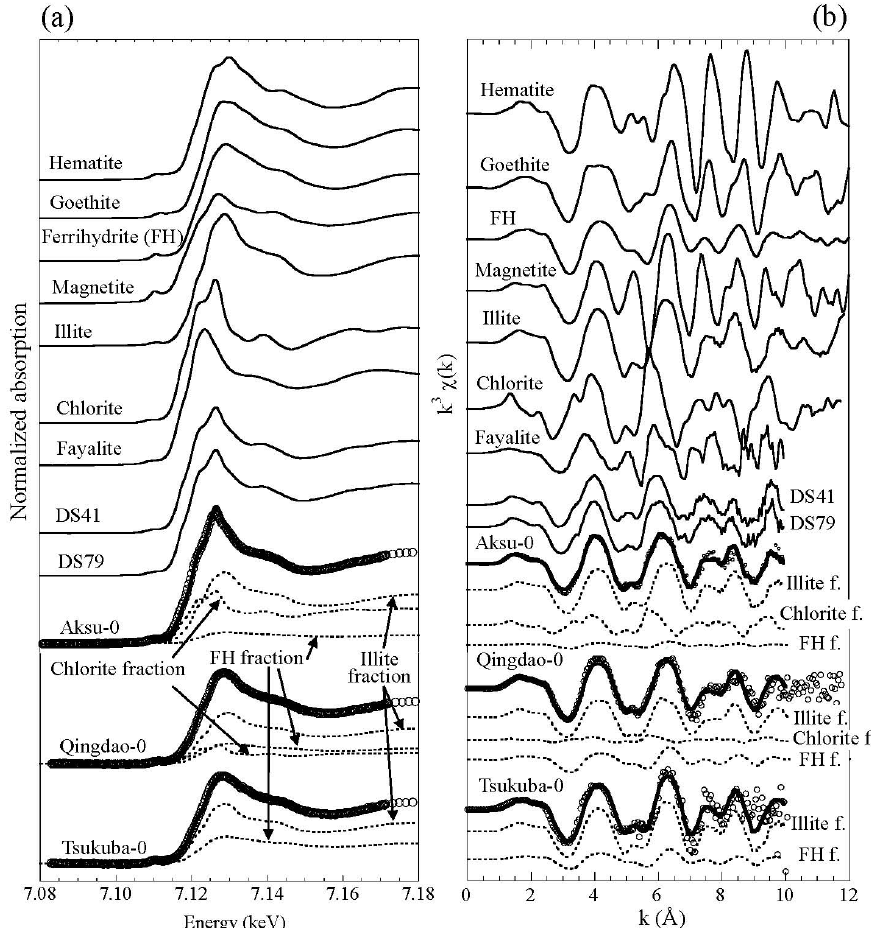
Fig. 6. Selected XAFS spectra and the results of linear combination fit (LCF). (a) Normalized Fe K-edge XANES spectra of reference materials (hematite ( α -Fe 2 O 3 ), ferrihydrite, magnetite (Fe 3 O 4 ), illite (IMt-1), chlorite (CCa-2), and fayalite (Fe 2 SiO 4 )) and some Asian dust samples (Aksu-0 and Tsukuba-0). The sample name Aksu-0, for example, denotes that the sample was at stage 0 (particle diameter > 11µm as shown in Methods) collected at Aksu. Taklimakan desert sand is obtained as shown in Chang et al. (2000). (b) Normalized k 3 -weighted EXAFS spectra at Fe K-edge. Examples of the fittings of the sample spectra by LCF of illite, chlorite, and ferrihydrite (dotted lines) were also indicated for Ak-0 and Tk-0, respectively. Circles show experimental values, while the solid curve indicates the spectrum resulting from